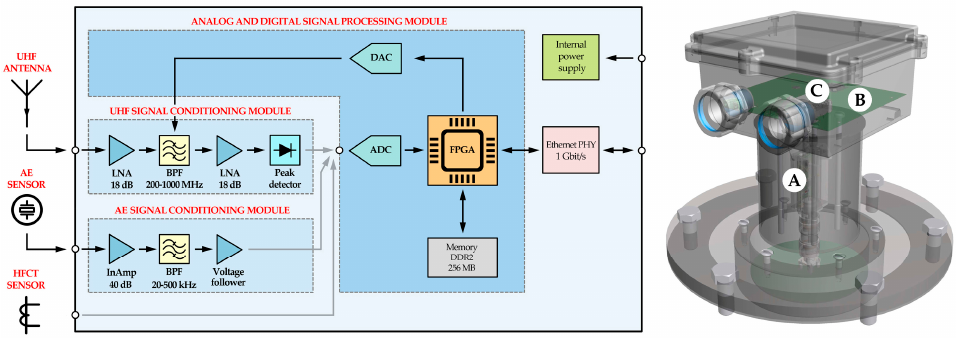
Figure 20. Schematic diagram of PD signal conditioning modules and A/D signal processing module and 3D drawing showing the mechanics of these modules: A = signal conditioning boards, B = analog-to-digital signal processing board, C = internal power supply module.